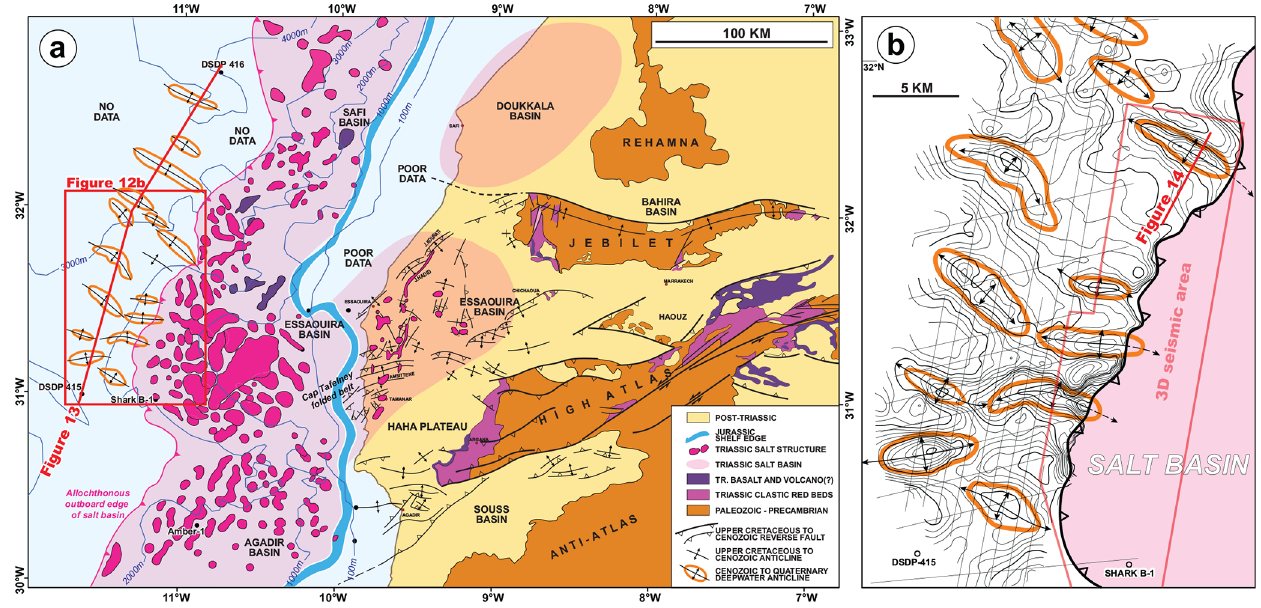
Figure 12. (a) Simplified structural map of central Atlantic Morocco, modified from Tari et al. (2017a). (b) Time structure map on a mid- Jurassic mapping horizon using 2D seismic data located just outboard of the salt basin (shown in light magenta). The prominent late Cenozoic inversion anticlines are shown by orange outlines.